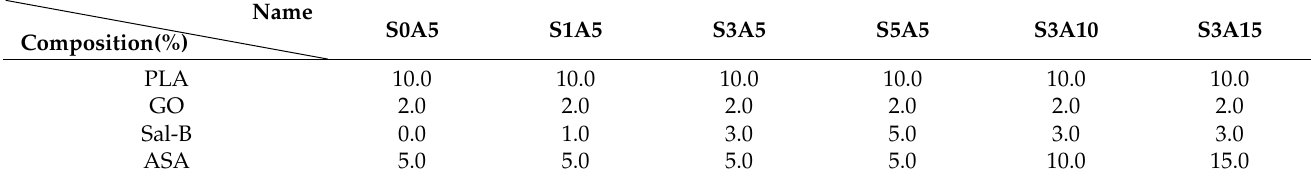
Table 1. The composition ratio of composite scaffolds with different drug contents.